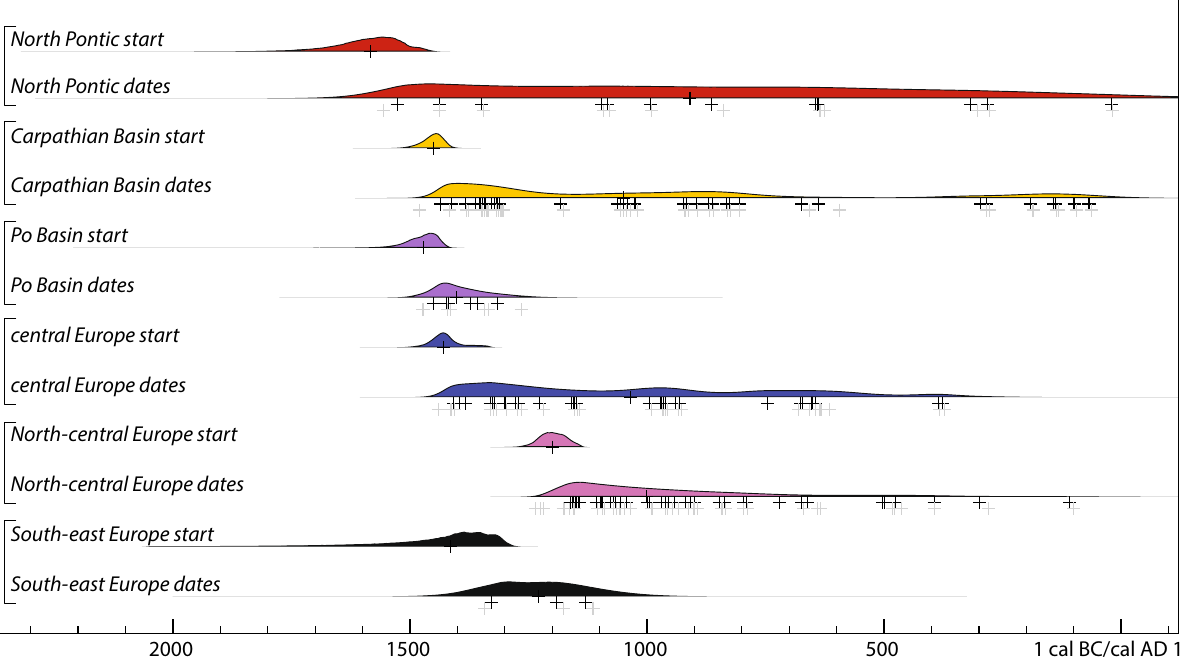
Figure 5. Modelled start date of millet cultivation (OxCal function Boundary) and temporal distribution of dated samples (OxCal function KDE_Plot) in each region. The crosses represent median dates of these distributions and of individual samples (gray: calibrated individually; black: modelled dates), providing an impression of differences in data density between